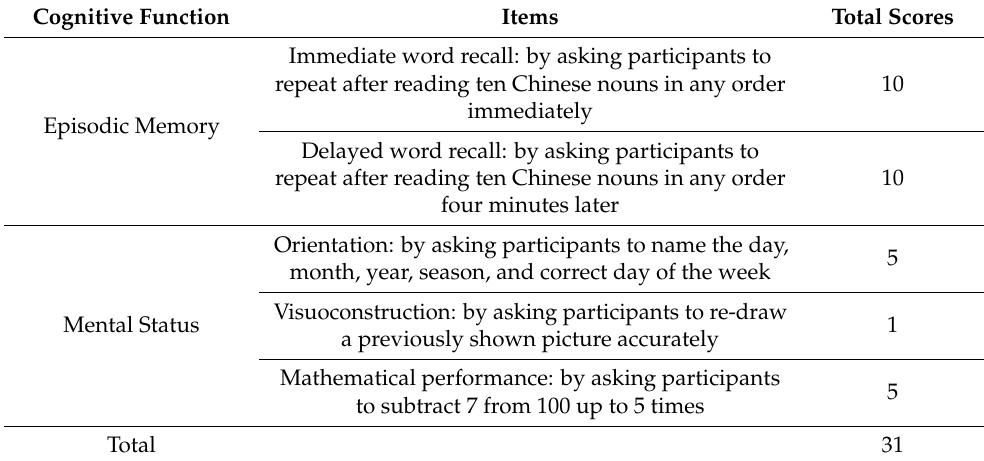
Table 1. Items adopted for the neuropsychological tests for China Health and Retirement Longitudi- nal Study Harmonized Cognitive Assessment Protocol